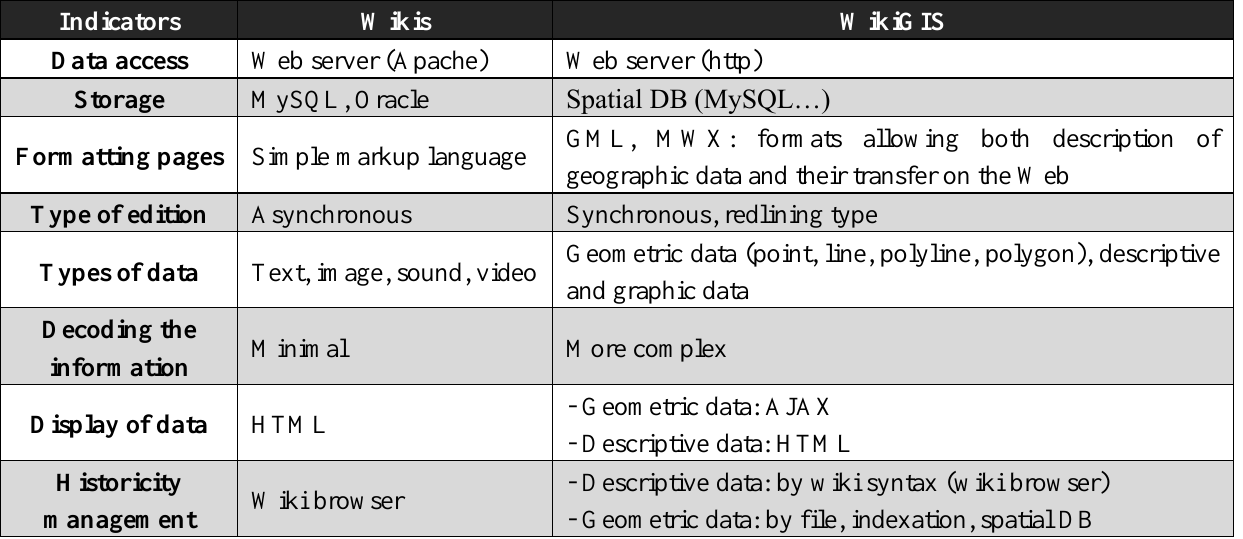
Table 1. Characteristics of the